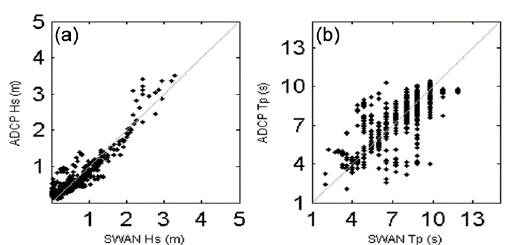
Table 5. Dates and forcing conditions of the SWASH simulations and results of the validation against observed shoreline position in Playa de